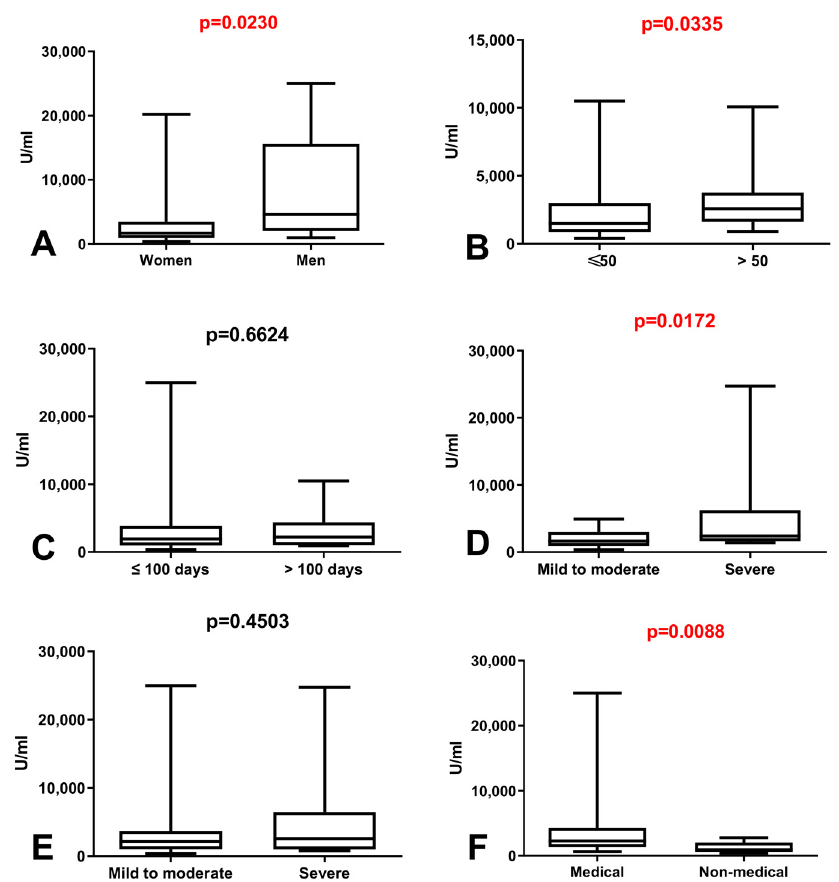
Figure 2. ( A ) Comparison of total anti-SARS-CoV-2 antibodies level between group of women and men with history of COVID-19. The data are presented as median (minimum–maximum). ( B ) Comparison of total anti-SARS-CoV-2 antibodies level between groups of patients before and after the age of 50 with history of COVID-19. The data are presented as median (minimum–maximum). ( C ) Comparison of total anti-SARS-CoV-2 antibodies level depending on the time between positive result of SARS-CoV2 PCR and vaccination date. The data are presented as median (minimum– maximum). ( D ) Comparison of total anti-SARS-CoV-2 antibodies level between groups of patients with mild to moderate and severe symptoms during COVID-19. The data are presented as median (minimum–maximum). ( E ) Comparison of total anti-SARS-CoV-2 antibodies level between groups of patients with mild to moderate and severe symptoms after vaccination in patients with history of COVID-19. The data are presented as median (minimum–maximum). ( F ) Comparison of total anti-SARS-CoV-2 antibodies level between group of medical and non-medical workers with history of COVID-19. The data are presented as median